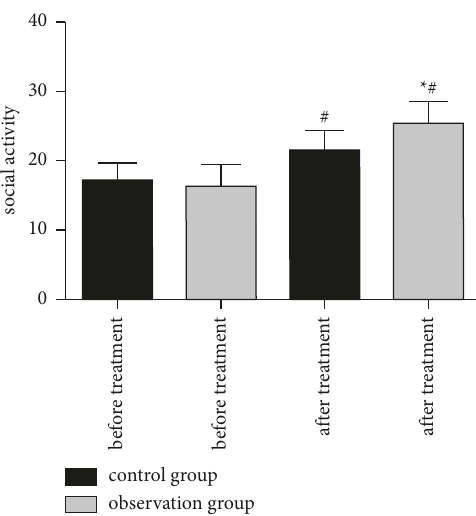
Figure 8: Visual function scores of the two groups of patients at different times. Compared with the same group before treatment, # ∗ P < 0 . 05; compared with the control group, ∗ P < 0 . 05.